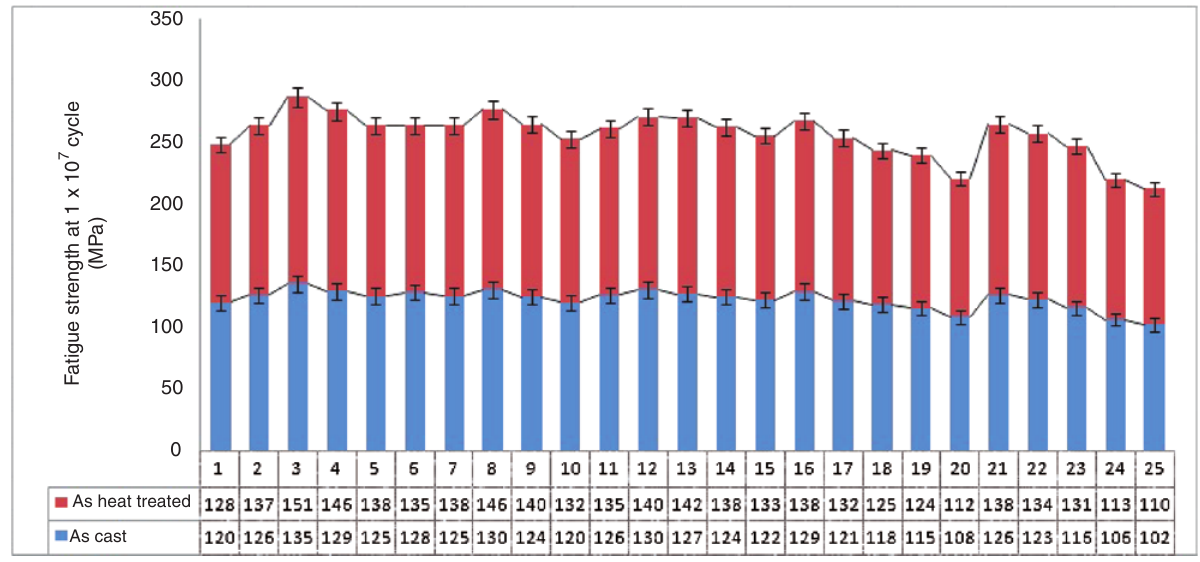
Figure 3: Fatigue strength of hybrid green MMCs.